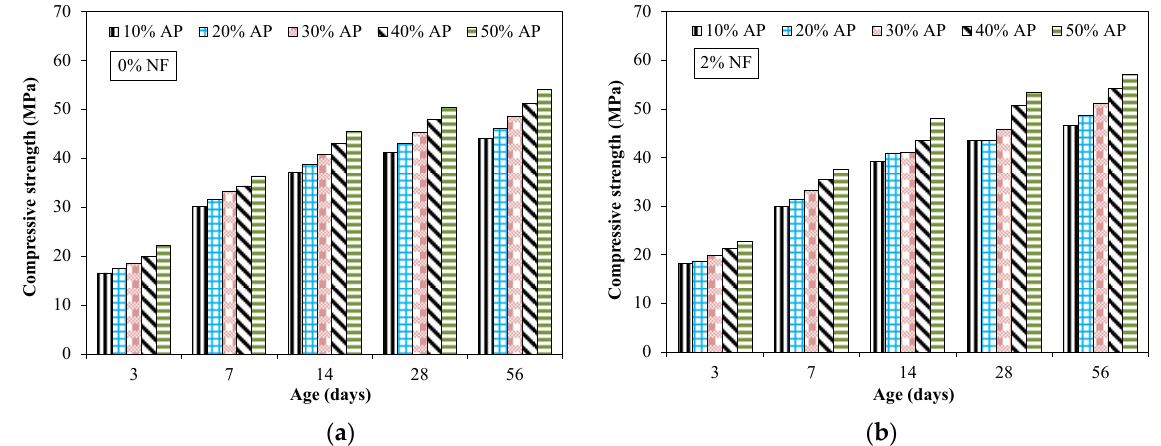
Figure 7. Compressive strength for specimens incorporating AP and fibers. ( a ) 0% fiber ( b ) 2% fibers. Table 5. Coefficient of variation for compressive strength